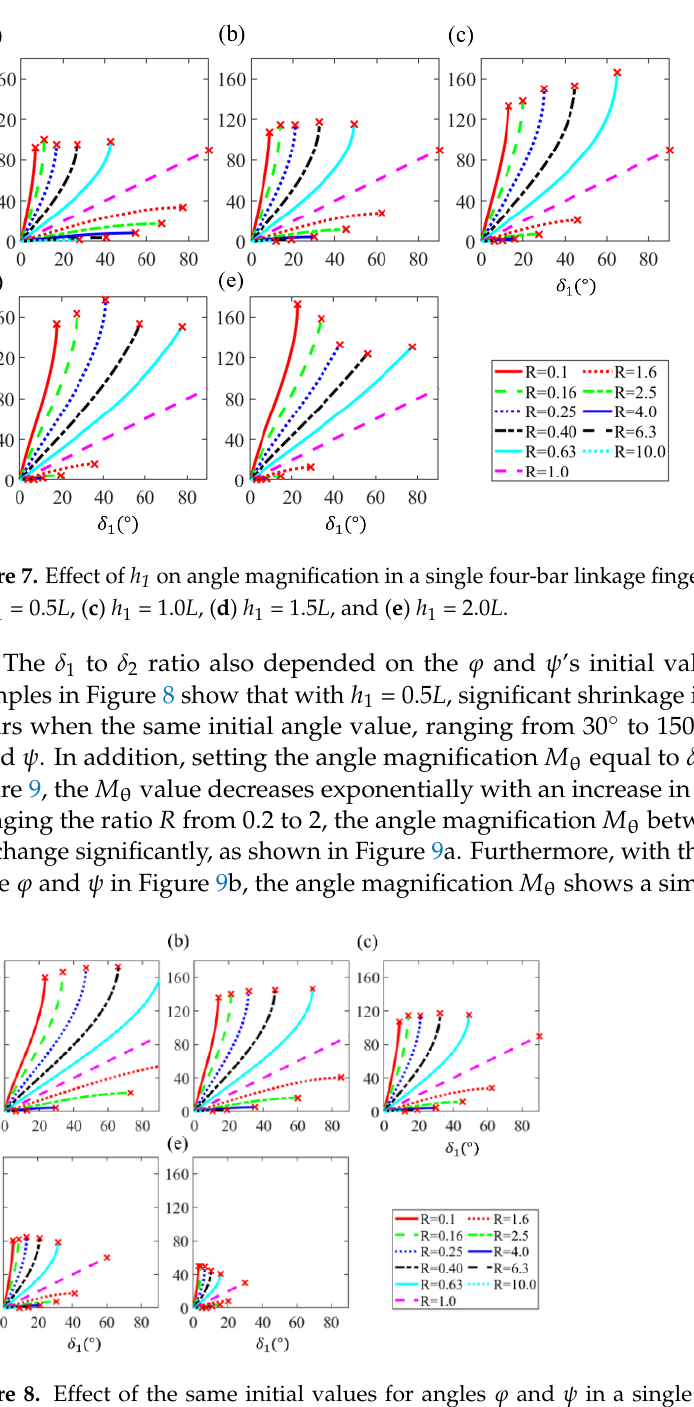
Figure 8. Effect of the same initial values for angles ϕ and ψ in a single four-bar linkage finger structure: (a) ϕ & ψ = 30 ◦ , (b) ϕ & ψ = 60 ◦ , (c) ϕ & ψ = 90 ◦ , (d) ϕ & ψ = 120 ◦ , and (e) ϕ & ψ = 150 ◦ .